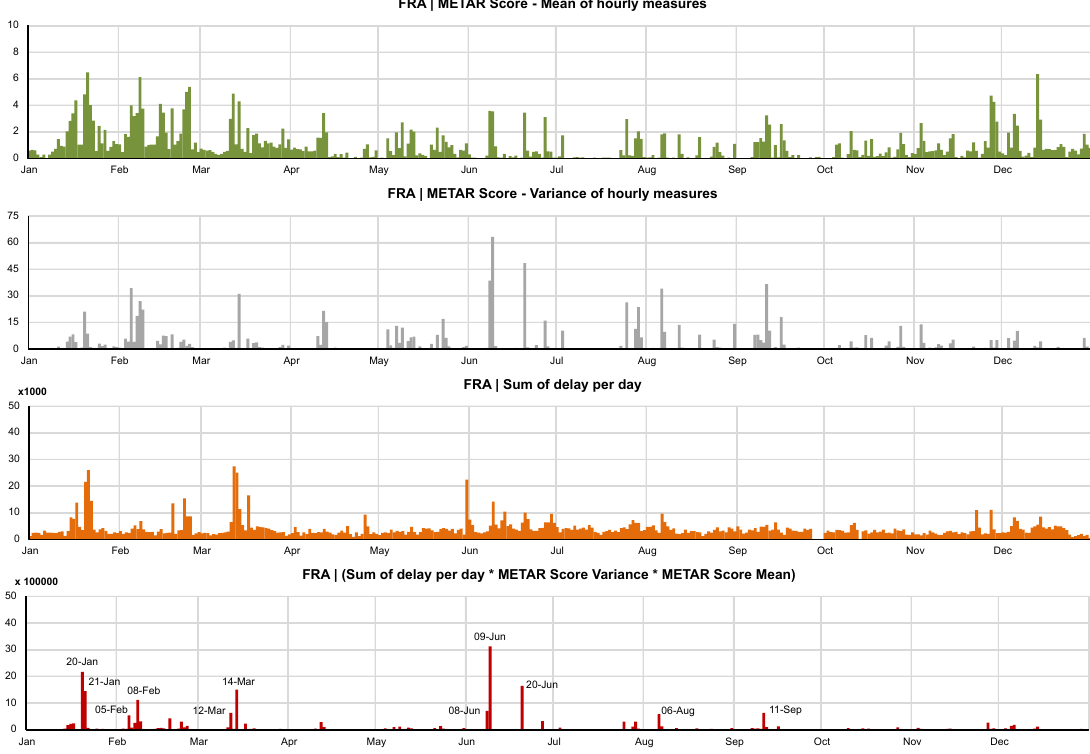
Figure 10. Histogram of daily values for ATMAP score at Frankfurt airport (FRA): mean of hourly ATMAP measures (above), variance of hourly ATMAP measures, sum of delay minutes per day, and multiplication of these values (below) to indicate relevant weather